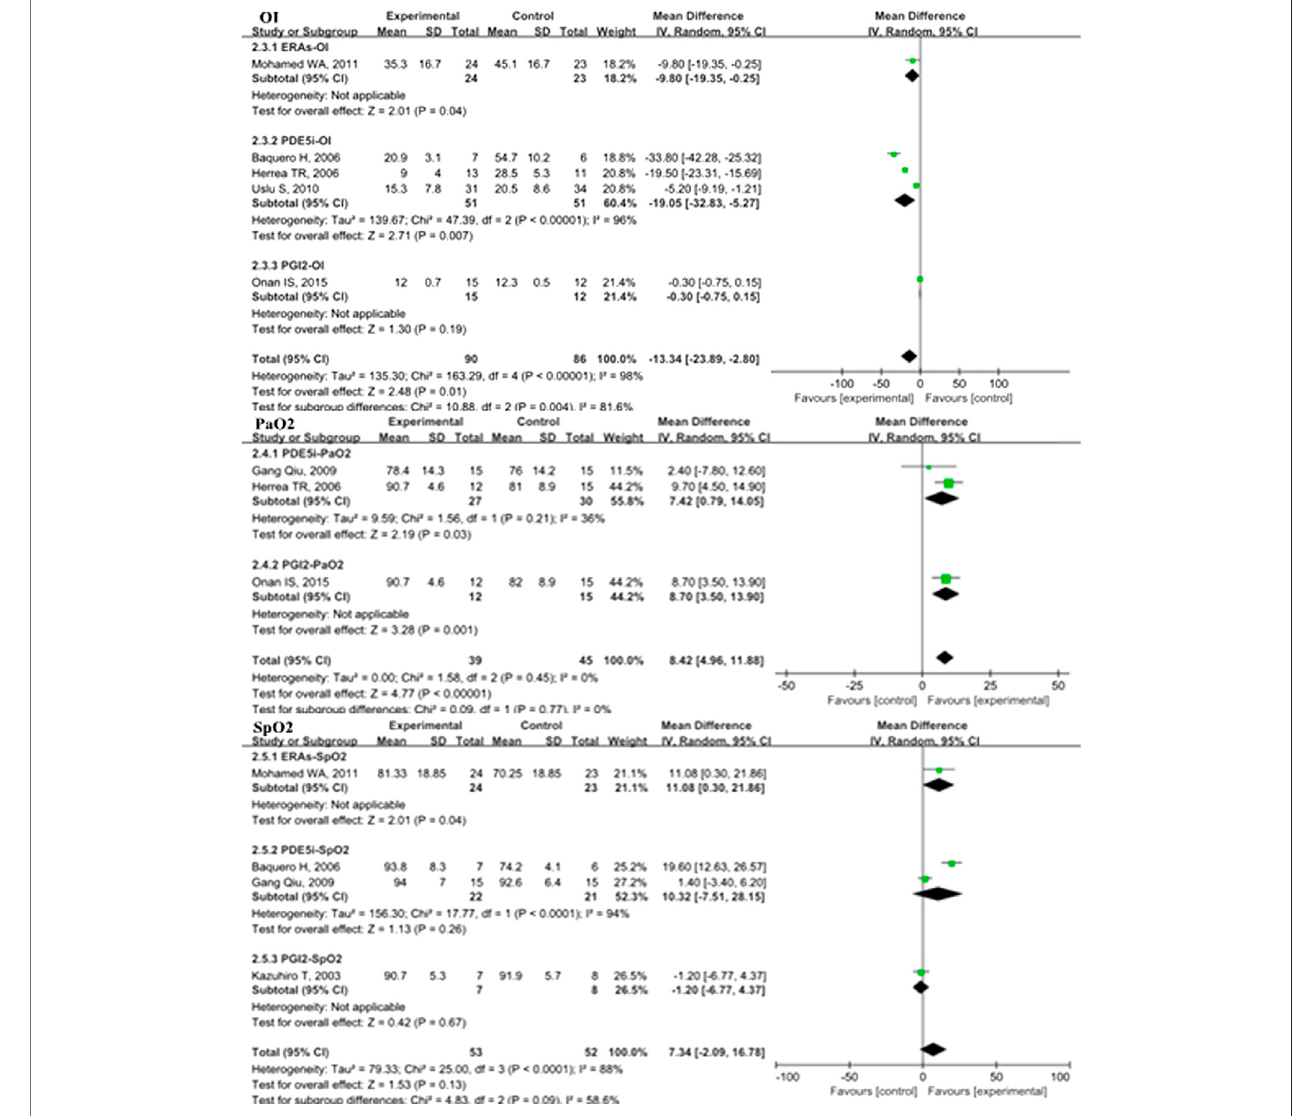
FIGURE 3 | OI, PaO2, and SpO 2 in pediatric PH patients treated with pulmonary vasodilators. Abbreviations: OI, oxygenation index; PaO2, partial pressure of arterial oxygen; SpO2, pulse oxygen saturation. Other abbreviations are de fi ned in Figure 1 .